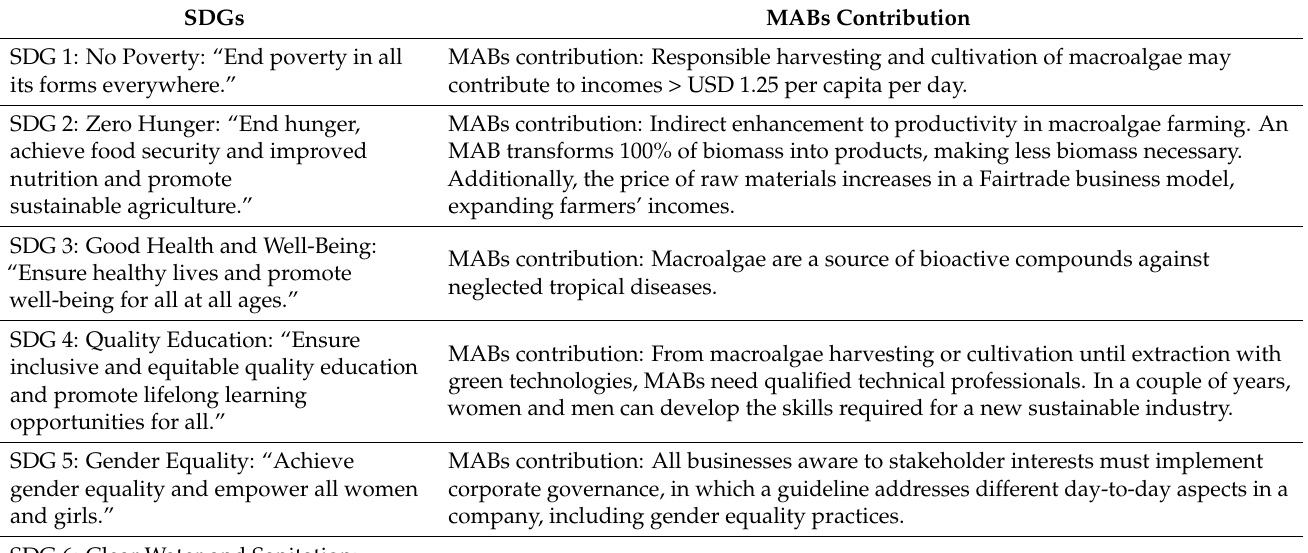
Table 8. Definition of the Sustainable Development Goals (SDGs) of the United Nations (UN) (United Nations, 2022) and how MABs can contribute according to UN targets and indicators. SDGs MABs